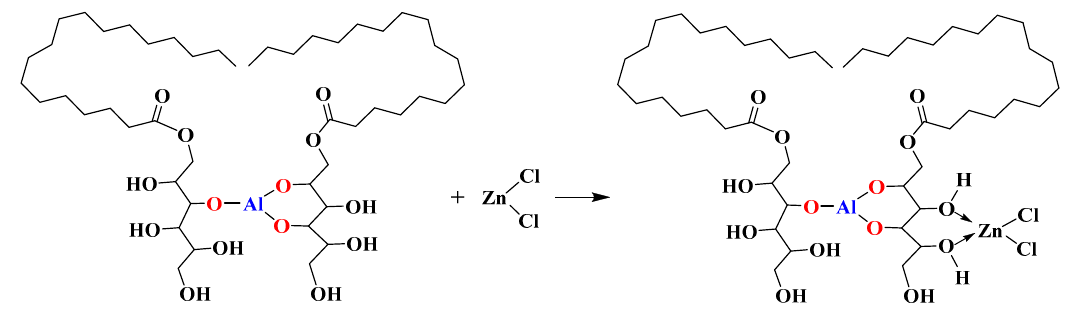
Figure 11. Thermal aging test of PVC samples compounded with different stabilizers and heated at 180